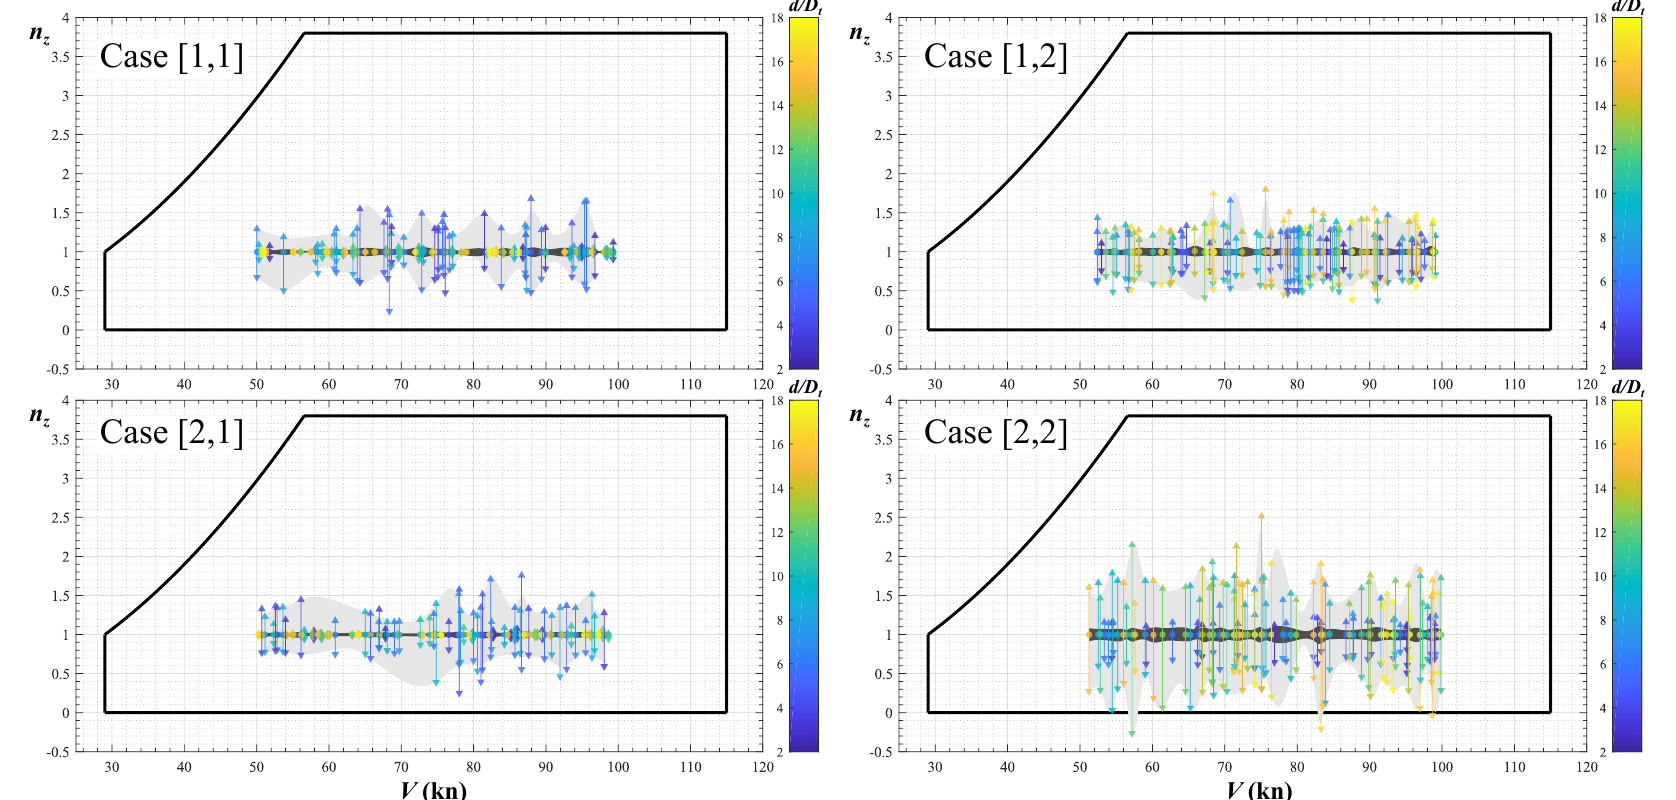
Figure 10. V - n diagram in the positive load factor semi-plane for the custom modelled aircraft. Design stall speed in clean configuration is V S = 29kn, design cruise speed is V C = 87kn and dive speed is V D = 115kn. The positive limit maneuvering load factor is 3.8. The maximum ( (cid:78) ), minimum ( (cid:72) ) and average ( • ) values of the aircraft normal load factor n z are plotted at the corresponding wake encounter speed for the random S ET 3 of each of the four ALM cases. The color grading B indicates the normalized distance downwind the turbine at which the crossing has taken place. The light grey background highlights the clusters of data that presents = 1 line envelopes the load factor values contained within the interval [ µ − σ , µ + σ ] . From this positive or negative peak values. The dark grey area along the n z B visualization, it is more clear that the wake encounter as simulated in this work poses no threat for the control and structural safety of the